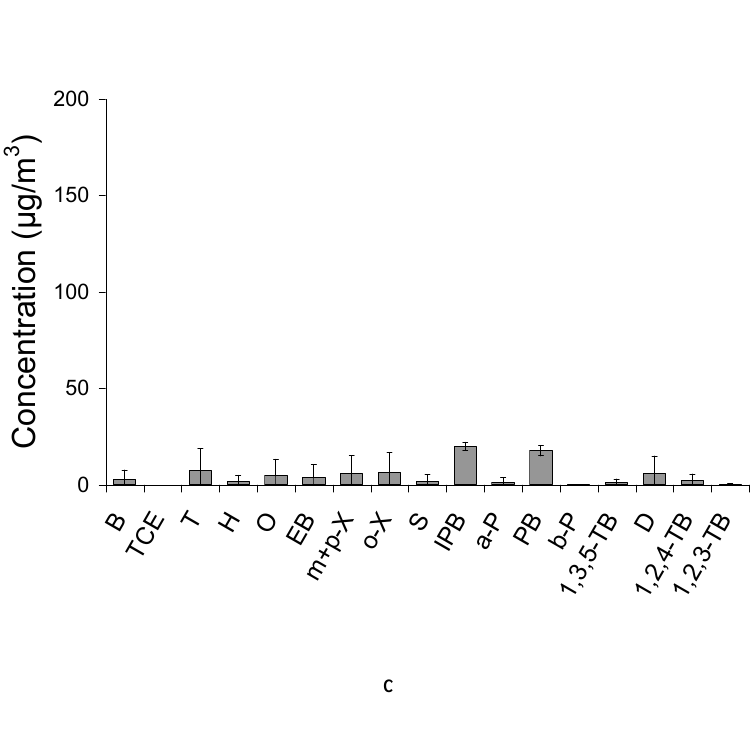
FIGURE 1. VOC profile obtained from the analyses of dosimeters for each exposed group: (A) V, (B) MW, and (C) HPW. Bars indicate standard deviation. Acronyms used for VOC are shown in Materials and Methods.